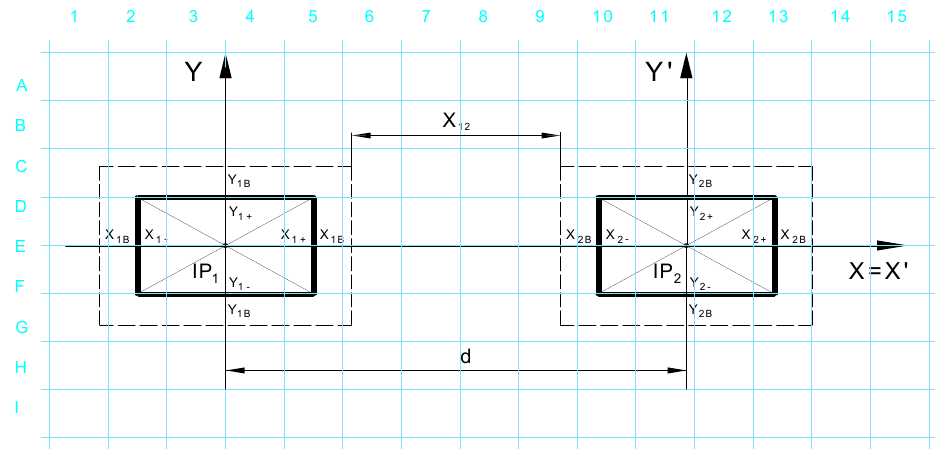
Figure 1. Model of building elements relationships of production systems 1 - 0 x [28]. The condition must be met in order to avoid collisions of the distributed elements. The insertion point of the construction element of the production system is placed on the axis o y :